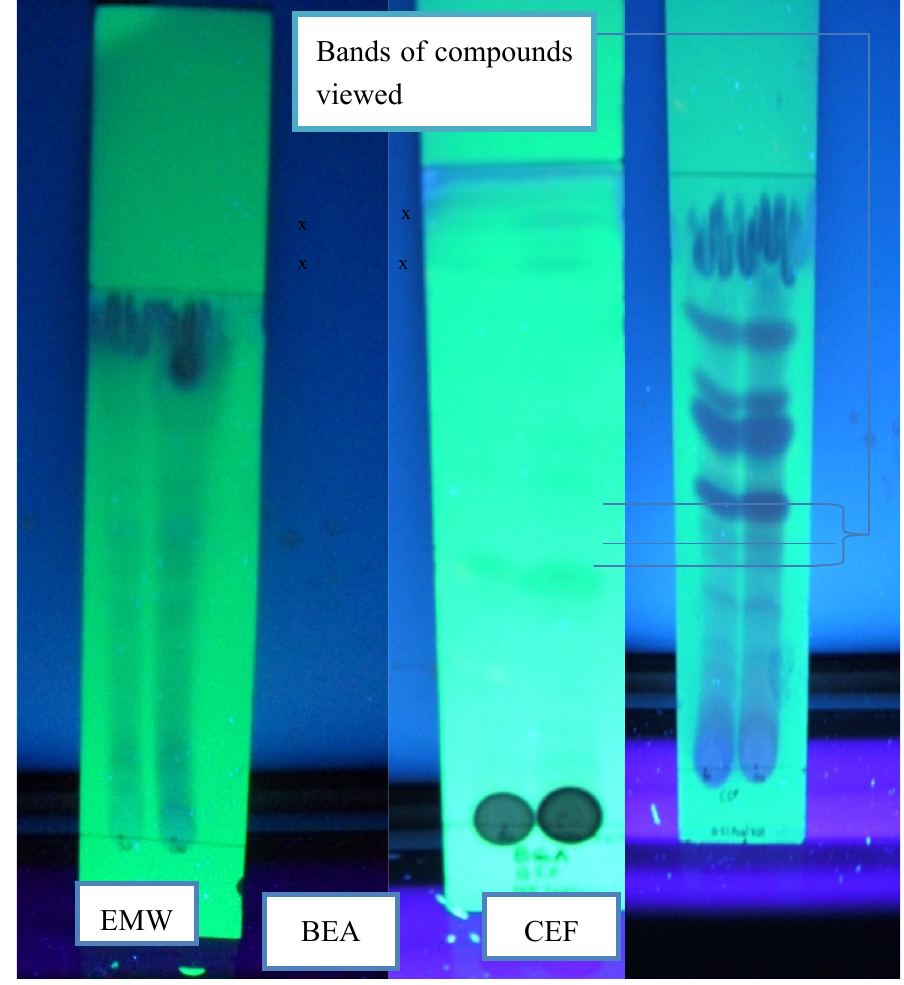
Figure 1. TLC plates showing separation of compounds using different solvent systems viewed under 302 nm (UV).